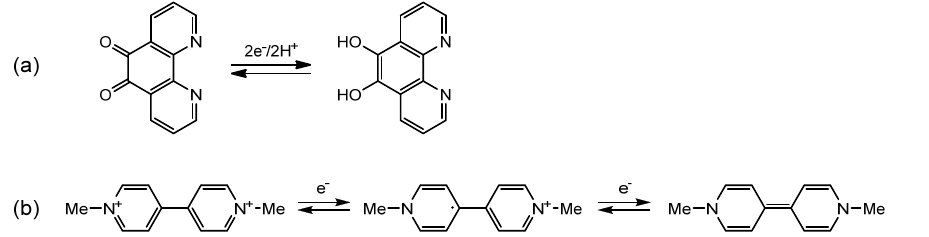
Scheme 1. ( a ) Direct reversible 2e − / 2H + process of dpq, and ( b ) successive reversible 2e − process of methyl viologen.